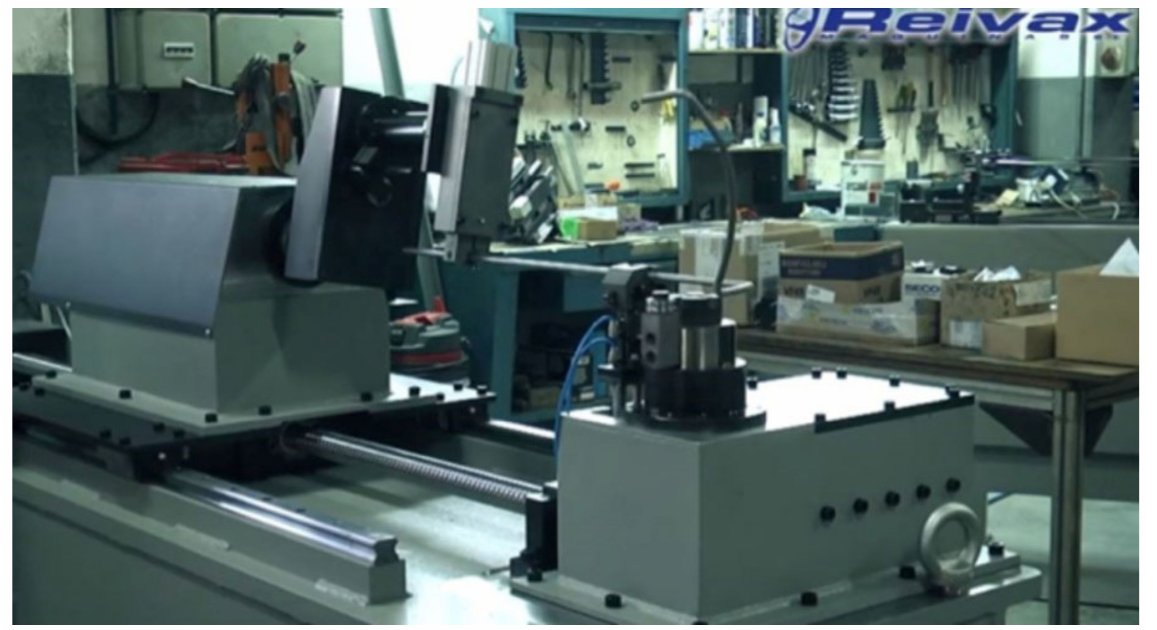
Figure 14. Wire-bending equipment 3D-CN-8-M [36].